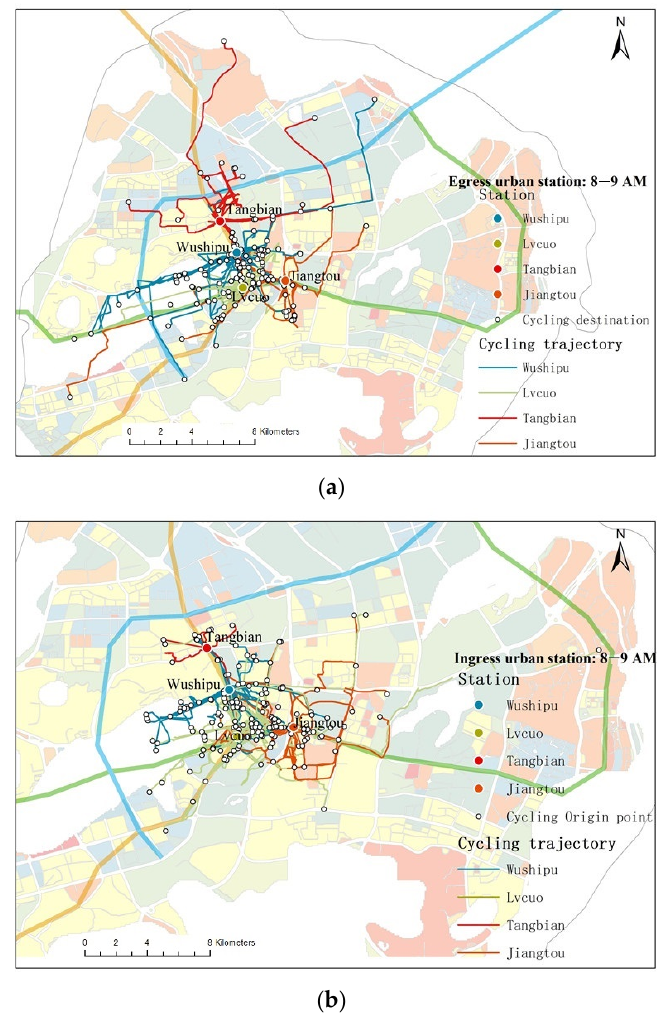
Figure 10. ( a ) Cycling trajectory for egress metro station from 8:00 to 9:00 a.m. ( b ) Cycling trajectory for ingress metro station from 8:00 to 9:00 a.m.